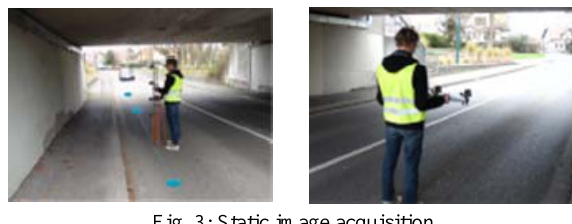
Fig. 3: Static image acquisition